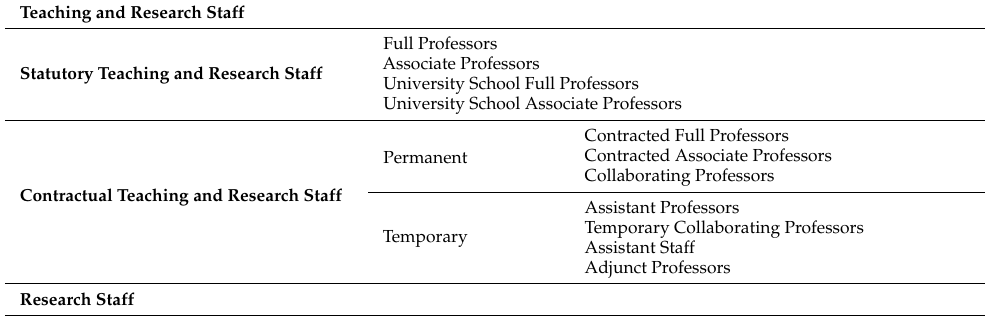
Table 1. Job categories of the teaching and research staff of the Universitat Polit è cnica de